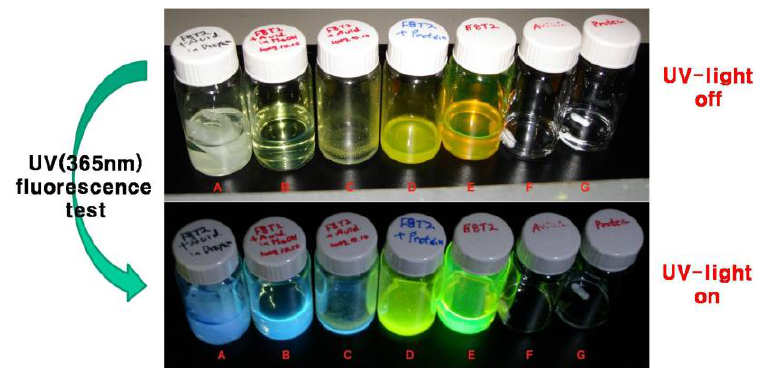
Figure 6. UV (365 nm) fluorescence test with BSA- or avidin-treated biotinylated F8T2. ( A ) biotinylated F8T2 with Avidin in dioxane. ( B , C ) biotinylated F8T2 with Avidin in MeOH. ( D ) biotinylated F8T2 with BSA in MeOH. ( E ) biotinylated F8T2 in p -Xylene. ( F ) Avidin in water. ( G ) BSA in water (up: UV light off; down: UV light